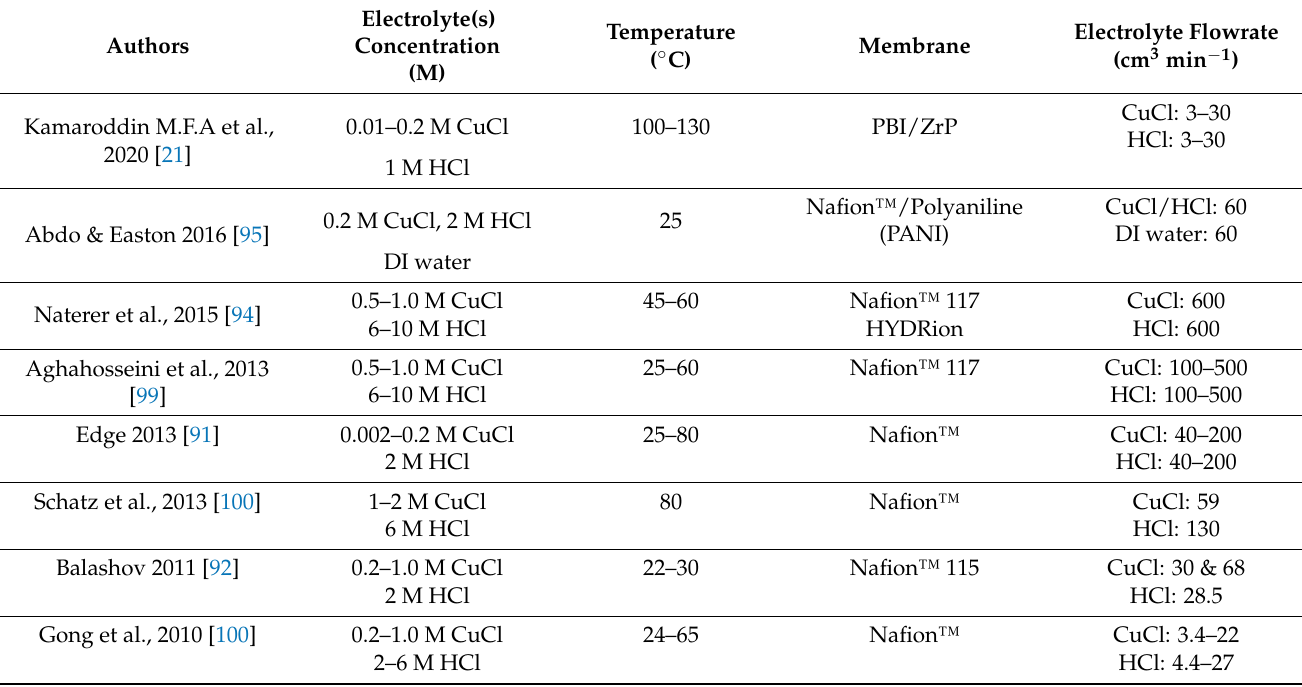
Table 1. CuCl-HCl electrolysis system for hydrogen production via hybrid PBI/ZrP and Nafion™